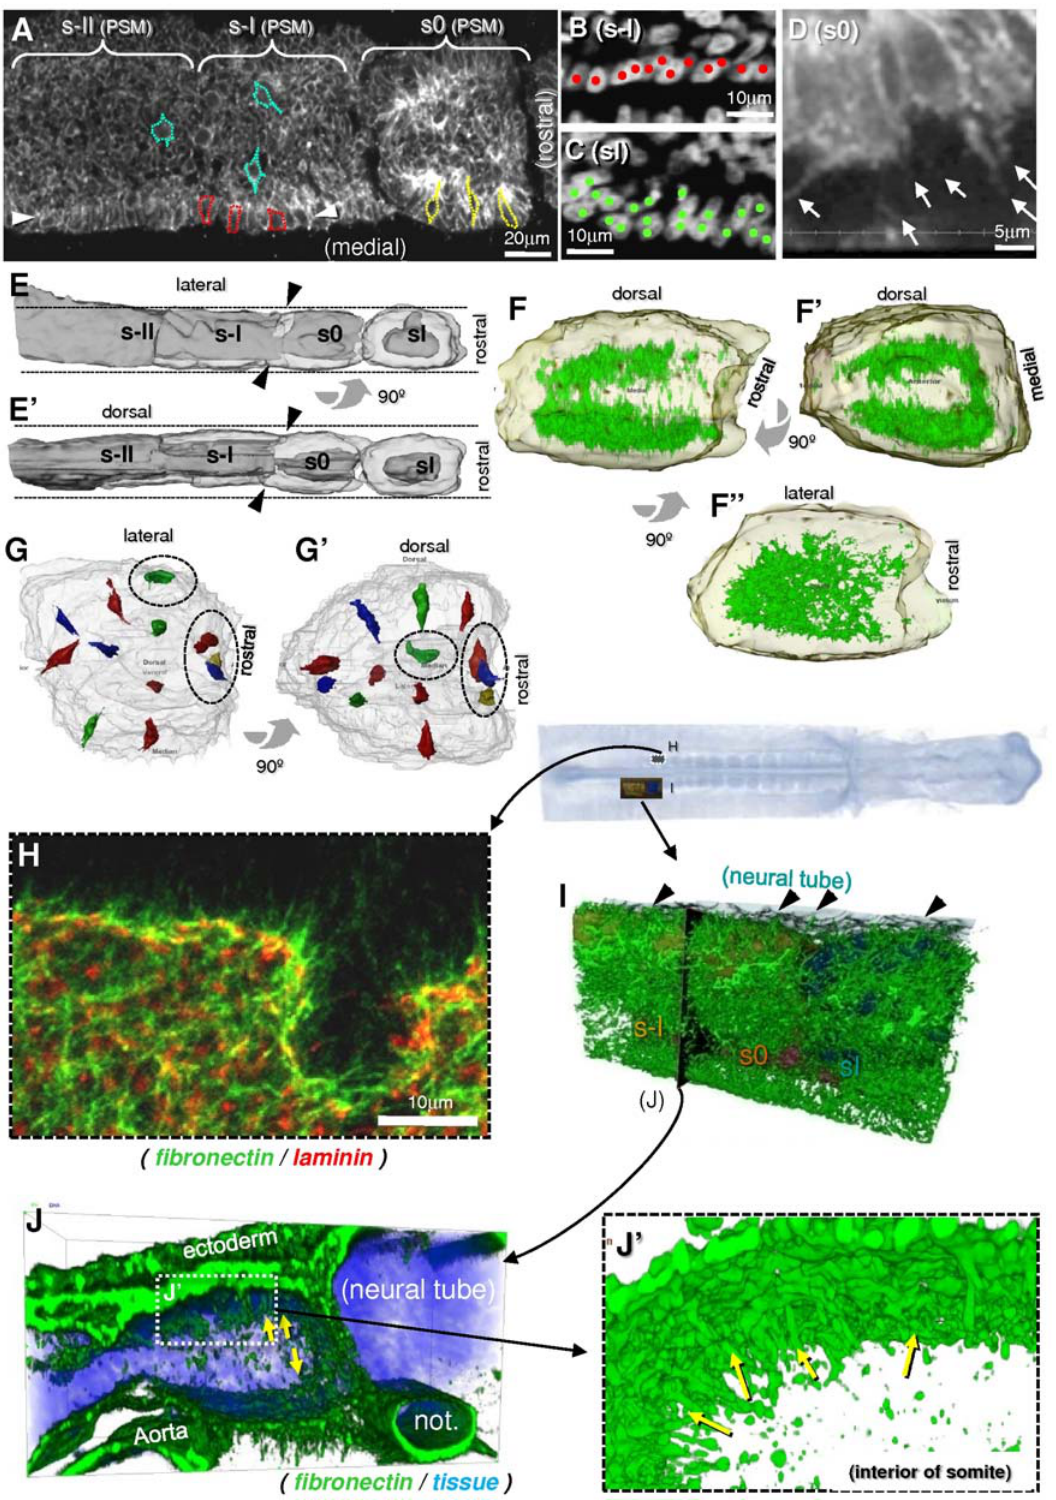
Figure 1. Cell organization, polarization and matrix organization in rostral PSM and epithelial somites (see also Videos S1 and S2). A ) Coronal confocal section of chick embryo PSM immunostained for N-cadherin showing s-II, s-I and s0. Different cell shapes can be recognized: mesenchymal polygonal cells (blue), medial cuboidal cells (red) which are aligned forming a cuboidal epitheloid layer (between arrowheads) and elongated spindle-shaped cells (yellow). Red cells in s-I have started elongating and yellow cells in s0 are spindle-shaped. B and C ) Coronal confocal sections of a chick embryo PSM stained for DNA showing a detail of the medial epithelium at the level of s-I (B) where cell nuclei are round and basally aligned (red dots), and at level sI (C), where they are oval-shaped and non-aligned basally as in a pseudostratified epithelium (green dots). D ) Coronal confocal section of a chick embryo PSM stained for N-cadherin, showing in detail the extension of pseudopodia that connect the PSM cells to